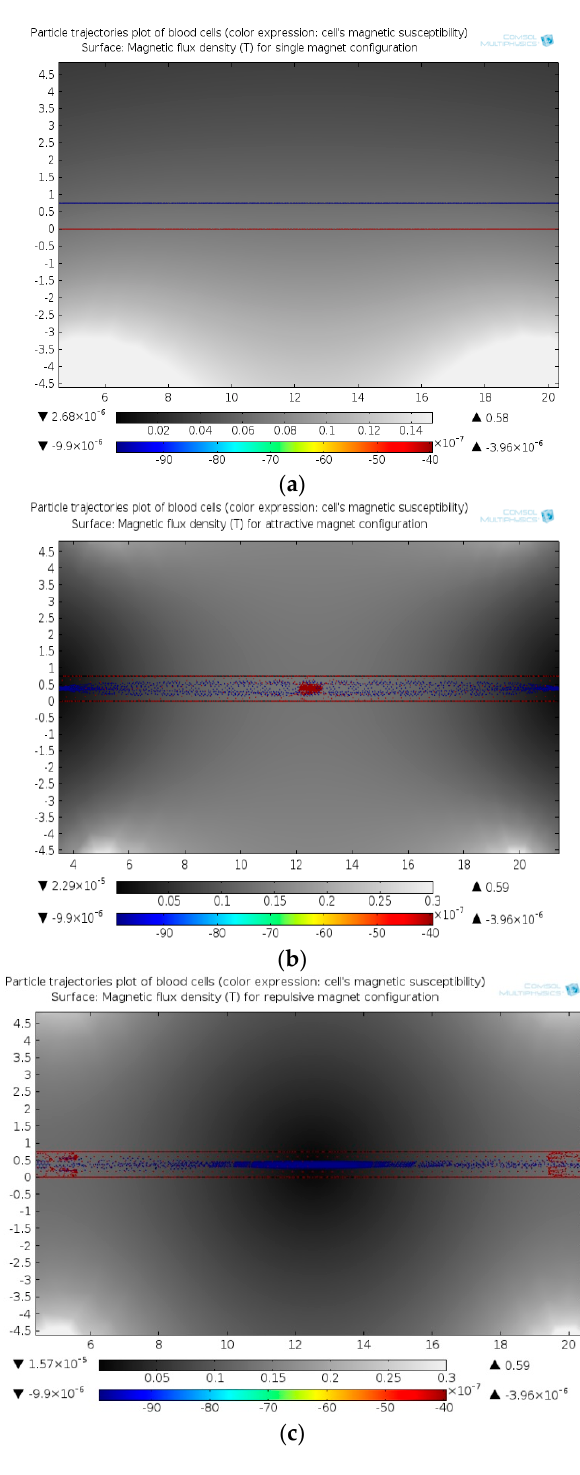
Figure 3. Cell trajectories within the microchannel: ( a ) Single magnet; ( b ) Magnet in attraction; ( c ) Magnet in repulsion. The grey scale and colour spectrum bar showed the magnetic flux density and magnetic susceptibility of cells, respectively.